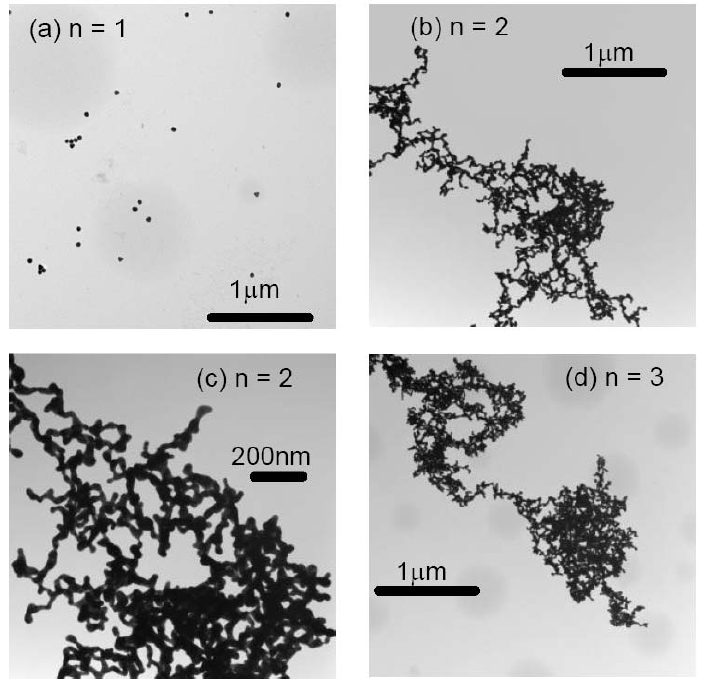
Figure 9. The TEM images of 20 nm gold colloids (a) n = 1 (pH 7), (b) n = 2 (pH 4), (c) n = 2 (pH 4), and (d) n = 3